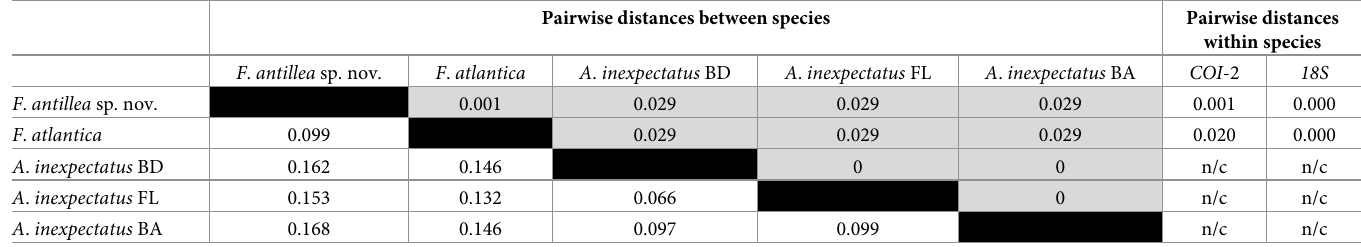
Table 5. Mean uncorrected pairwise distances (a) between and (b) within the Fortuynia ( F .) and Alismobates ( A .) species investigated in this study. (a) Values for COI -2 are given in white boxes, respectively, 18S in grey boxes. (b) n/c = not possible to estimate evolutionary distances because of insufficient sample size. Pairwise distances between species Pairwise distances within species F . antillea sp.